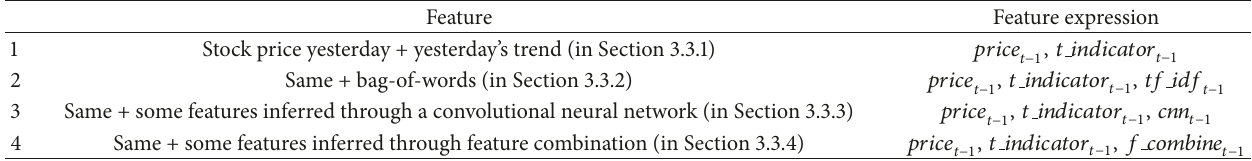
Table 6: Features of the prediction